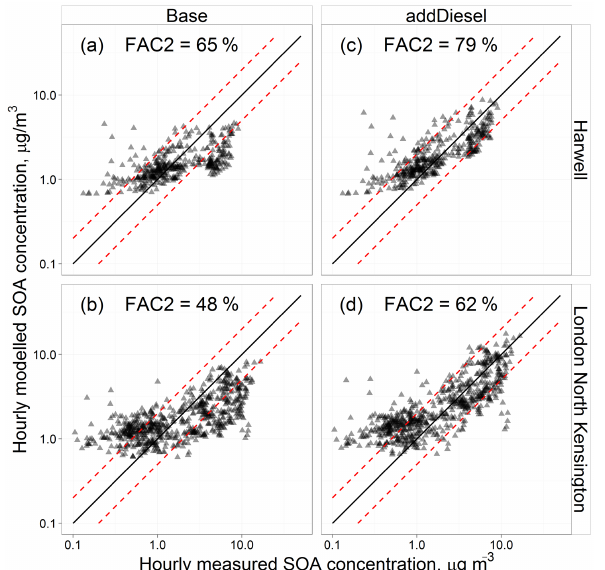
Figure 8. Scatter plots of measured and modelled hourly SOA concentrations during the summer 2012 IOP: (a) Base simulation at the Harwell rural background site; (b) Base simulation at the North Kensington urban background site; (c) addDiesel simulation at the Harwell rural background site; (d) addDiesel simulation at the North Kensington urban background site. The straight lines are the 2:1, 1:1, and 1:2 lines.